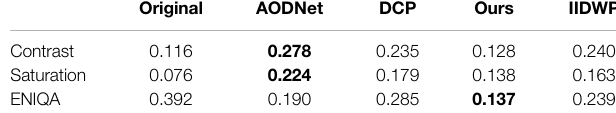
TABLE 2 | Indicator for the part of the image that contains a nearby scene. Original Contrast